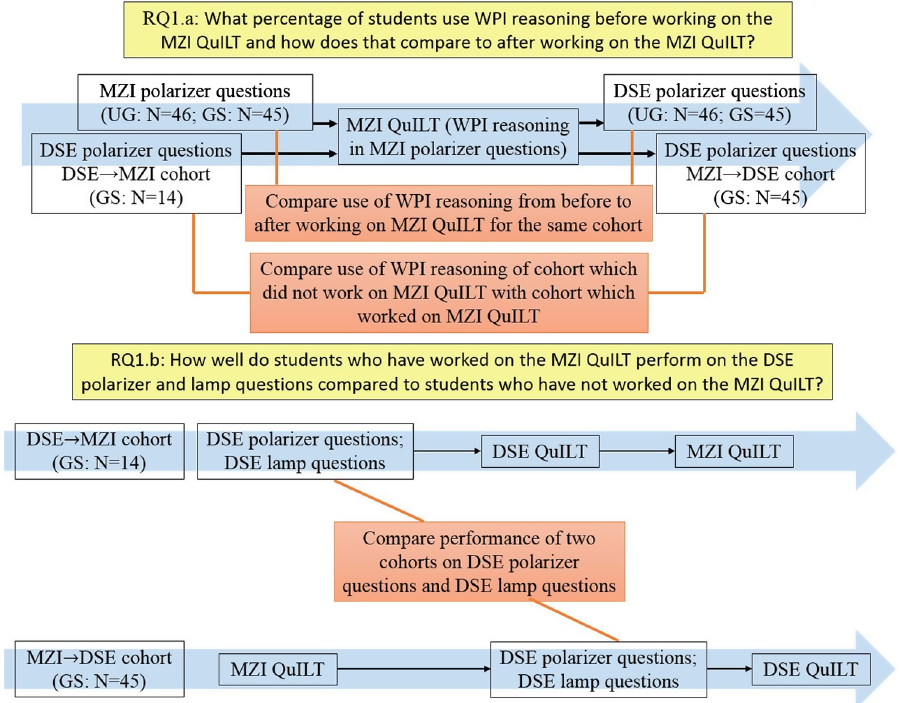
arrow.FIG. 1. Schematic description of the design used to investigate RQ1.a and RQ1.b. Abbreviations in the figure are undergraduate students (UG), graduate students (GS), and N refers to the number of students. The timeline of chronological order is from left to right as depicted by the blue arrows. All of the questions were given as pretests, i.e., the DSE polarizer questions in both RQ1.a and RQ1.b were always given before students worked on the DSE QuILT, and the MZI polarizer questions in RQ1.a were given before students worked on the MZI